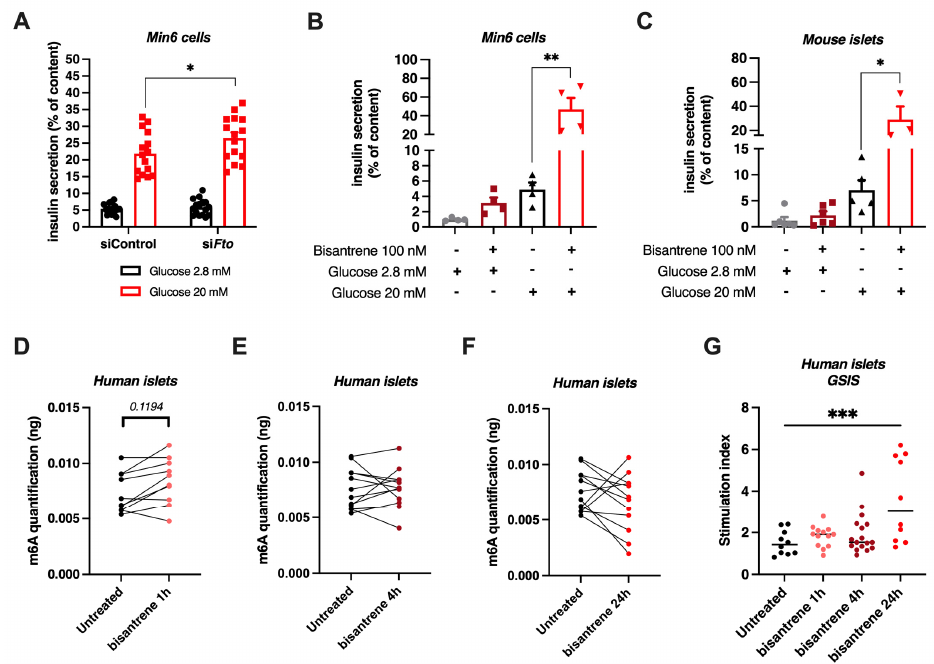
Figure 7. Effects of genetic or pharmacological FTO inhibition on glucose-stimulated insulin se- cretion in Min6 cells, mouse and human pancreatic islets. ( A ) GSIS after siRNA mediated Fto knockdown in Min6 cells ( n = 16). ( B , C ) GSIS after treatment of Min6 cells (( B ), n = 4) and primary mouse pancreatic islets (( C ), n = 6) with 100 nM bisantrene for 8 and 2 h, respectively. ( D – F ) Human pancreatic islets were untreated or treated with 100 nM bisantrene for 1 h ( D ), 4 h ( E ) and 24 h ( F ) and global m 6 A RNA methylation was quantified by ELISA. ( G ) GSIS of pancreatic human islets untreated or treated with 100 nM bisantrene for 1, 4 and 24 h. Stimulation index represents the